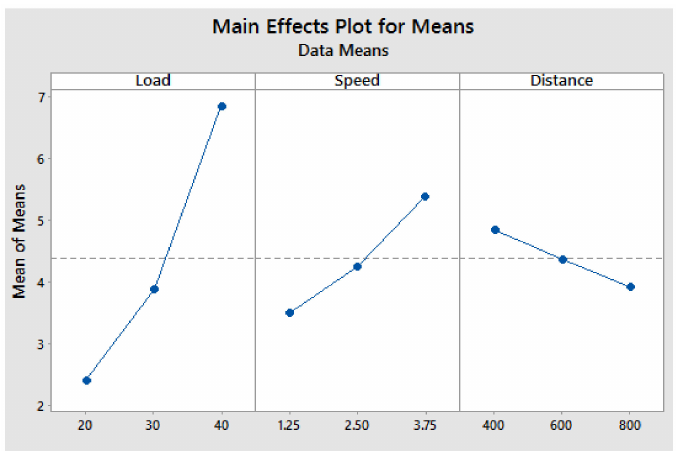
Figure 13. Mean effect plot for sample